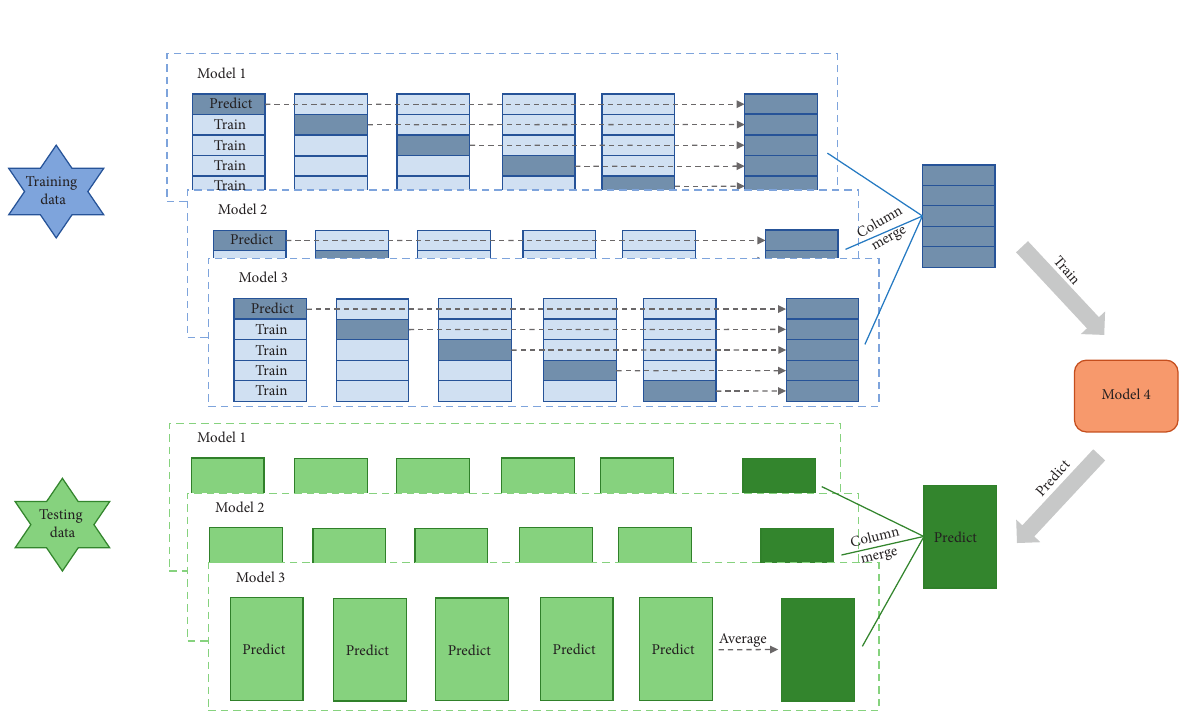
Figure 2: Flowchart of the proposed management